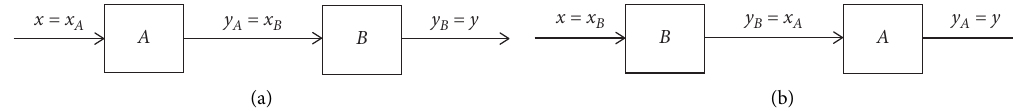
Figure 1: Cascade connection of the